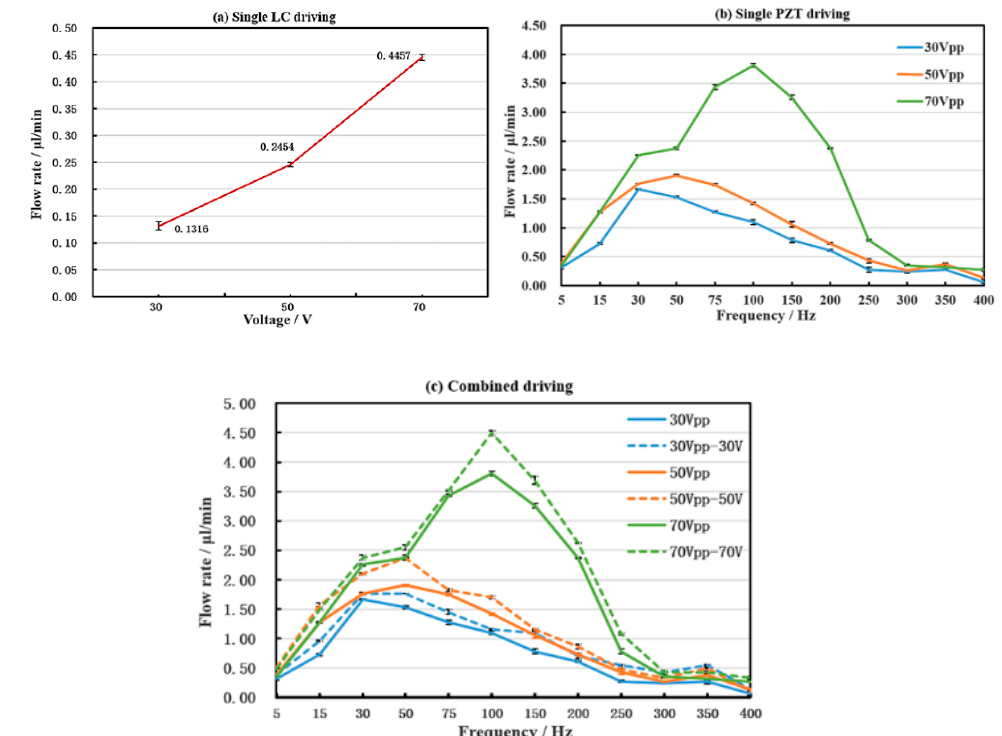
Figure 6. The flow rate of the micropump with ( a ) single LC driving, ( b ) single PZT driving, and ( c ) combined driving.